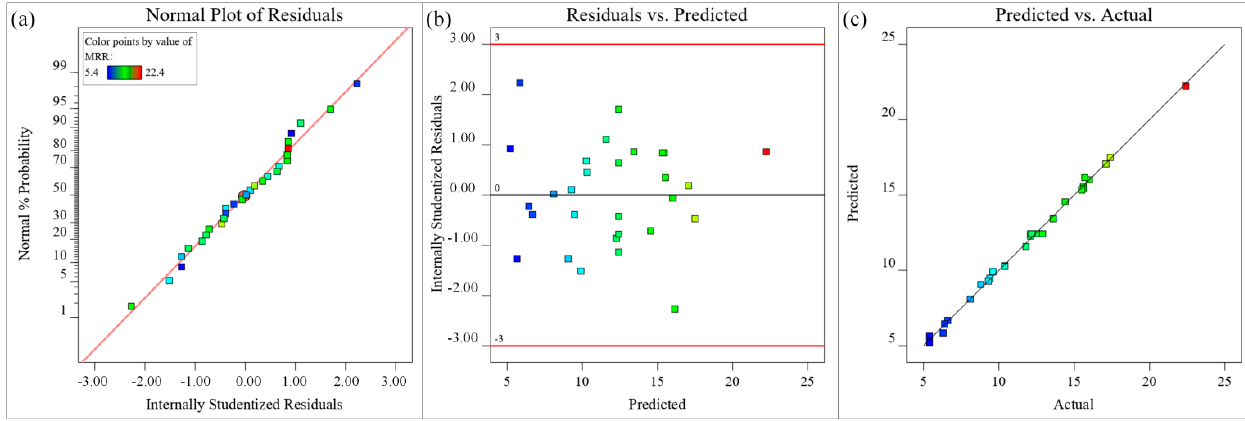
Figure 13. Diagnostic plots for MRR (µm): ( a ) Normal plot of residuals, ( b ) Residuals versus predicted plot, ( c ) Predicted versus actual values plot.